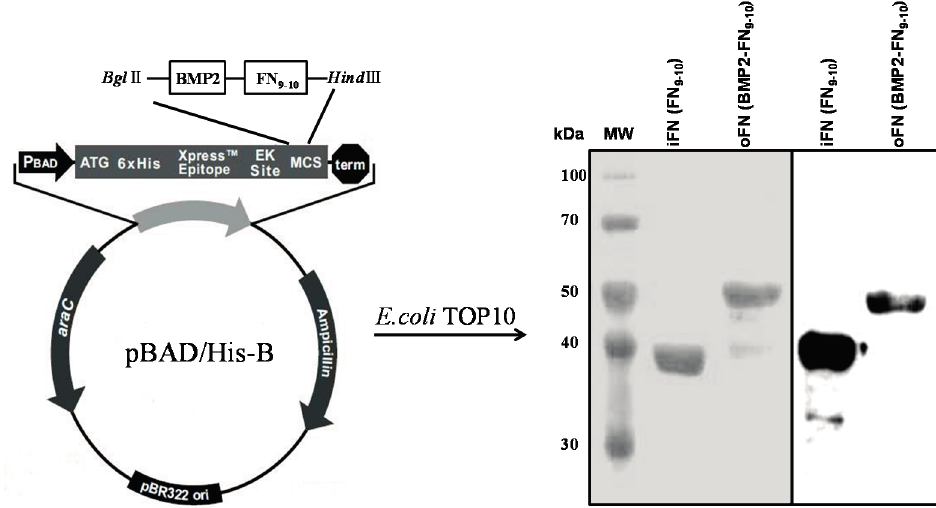
Figure 1. Cloning, expression, and purification of osteoinductive and integrin-binding fibronectin (oFN and iFN, respectively). The cDNA coding for bone morphogenetic protein-2 (BMP-2) and the ninth and tenth type-III fibronectin domains (FNIII 9-10 ) was cloned into the pBAD-HisB expression vector. Schematic representations of the fusion proteins and western blotting analysis of iFN (FNIII 9-10 ) and oFN (BMP-2-FNIII 9-10 ) are shown at 37 and 50 kDa, respectively.